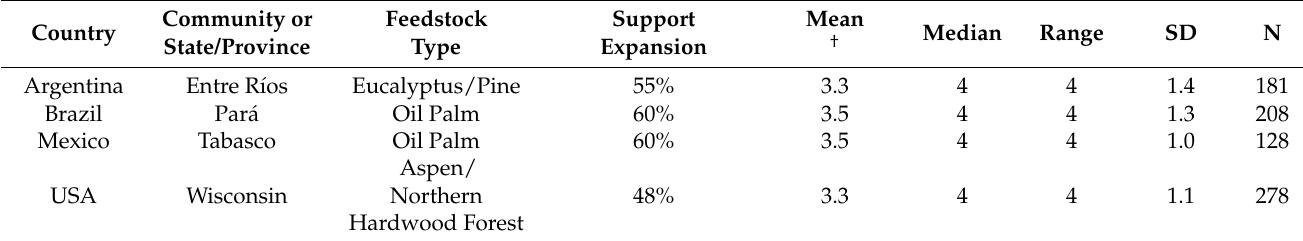
Table 2. Support for bioenergy feedstock or harvesting expansion (“Considering everything, I support the expansion.”). † Likert Scale: 1 = Strongly disagree, 5 = Strongly